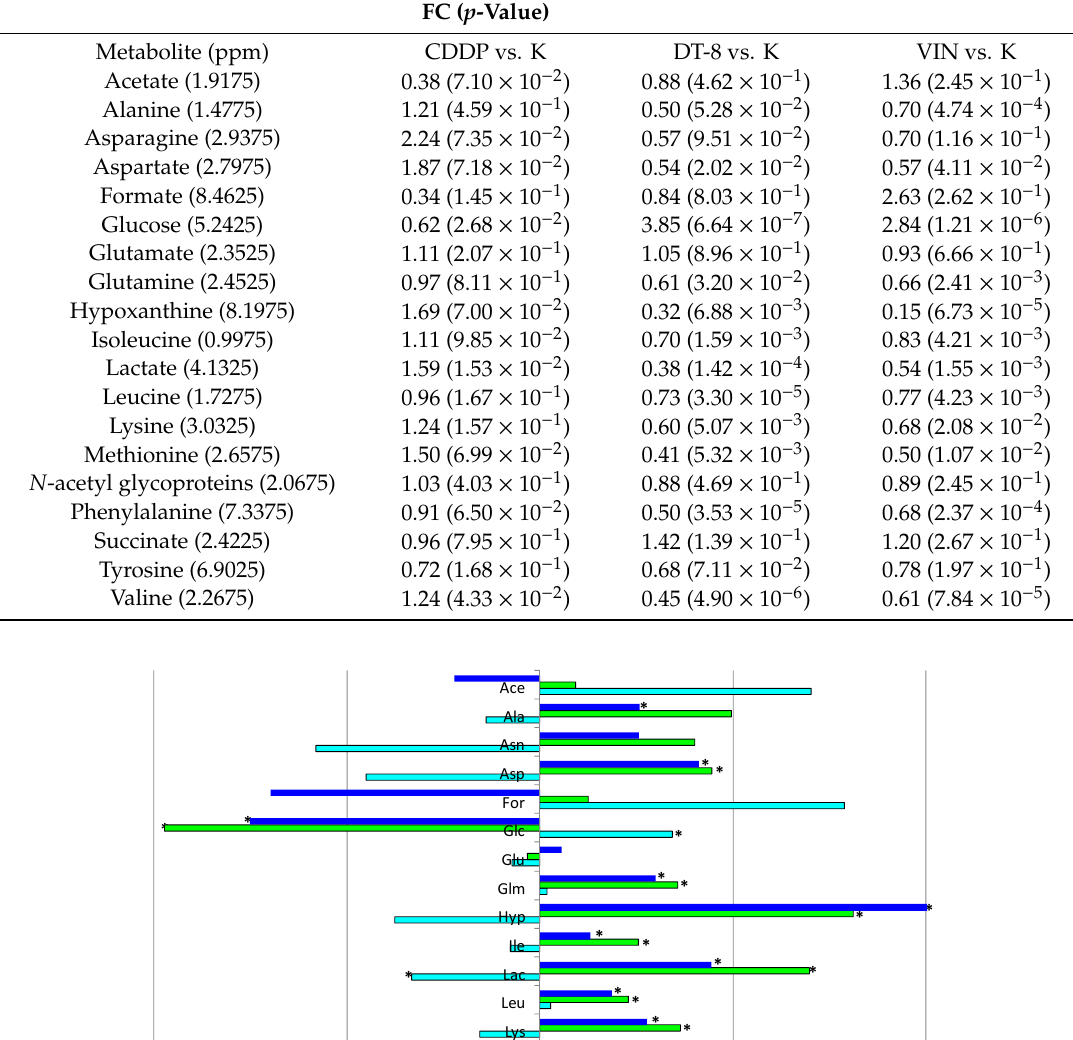
Table 2. Discriminating metabolites (the first column reported the corresponding bucket for each metabolite in parenthesis), with FC ratio (and p -value < 0.05) obtained by multivariate analysis (MVA) for CDDP vs. K, DT-8 vs. K and VIN vs. K cell lysates.